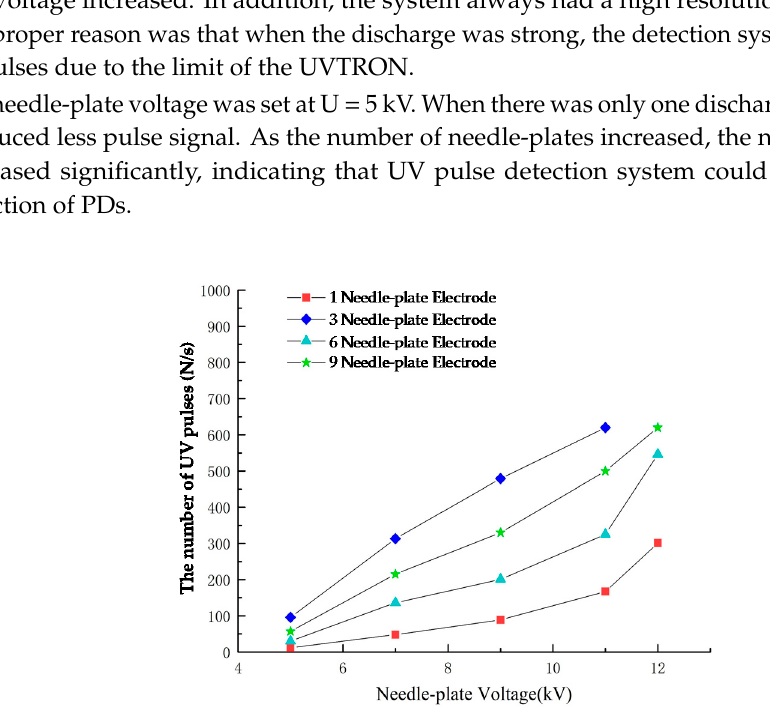
Figure 16. UV pulses under different numbers of needle-plates (D = 3 cm, L = 15 cm, U = 5 kV).